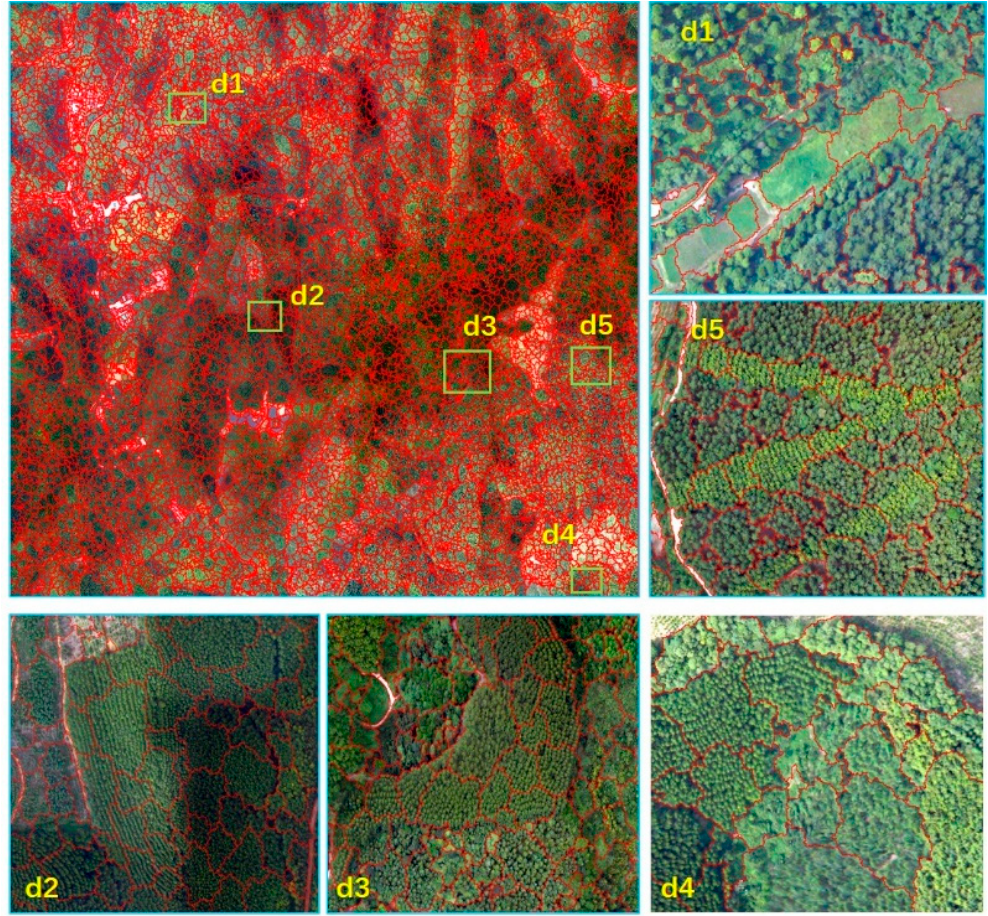
Figure 10. The results of segmentation and the enlarged details.